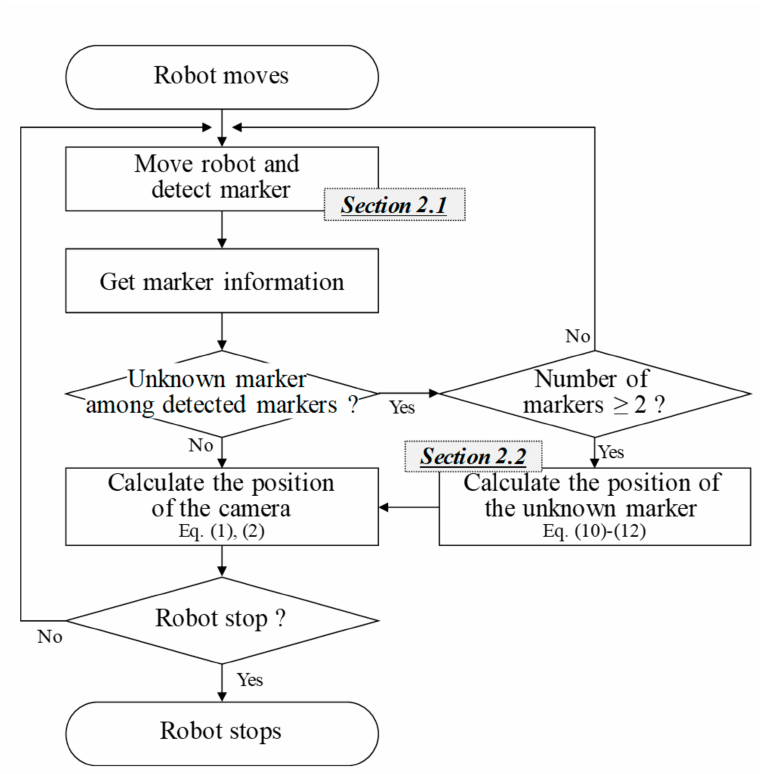
Figure 2. Flow chart of the proposed method.